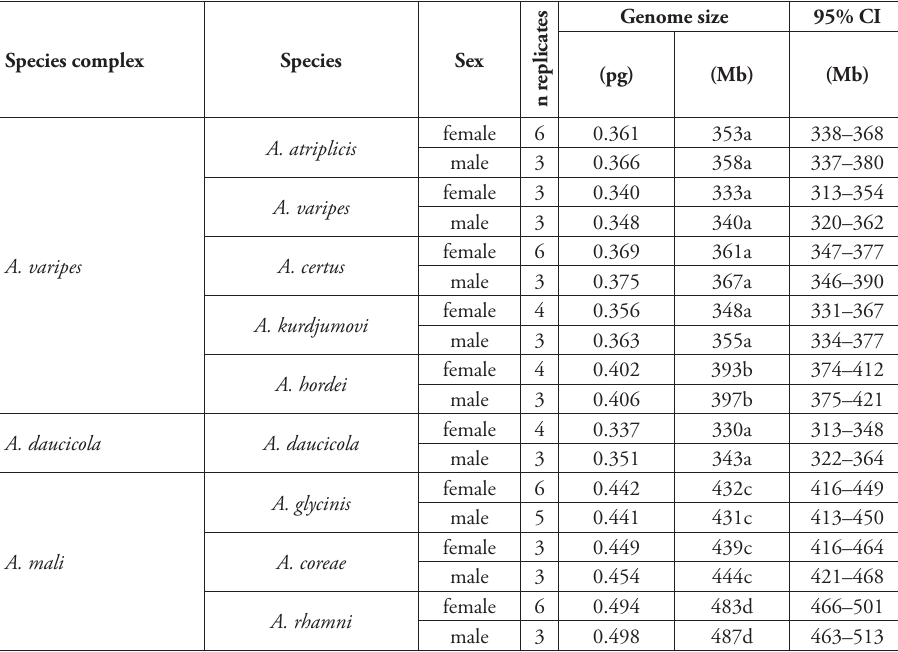
Table 2. Haploid genome sizes of nine Aphelinus species estimated from flow cytometry. Shared letters after means indicates that they do not differ